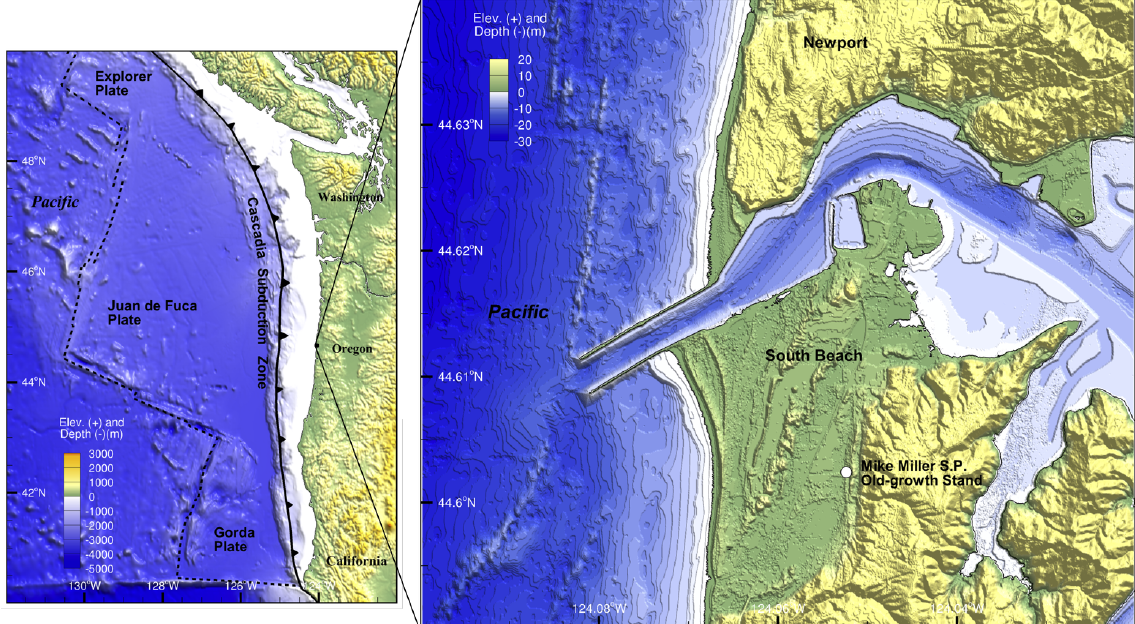
Figure 1. Map showing location of Newport and South Beach along the central Oregon coast. The white dot (at an elevation of 4m above mean higher high water, MHHW) shows the position of Mike Miller State Park in South Beach, which is the location of the Douglas-fir tree ( Pseudotsuga menziesii ) old growth stand whose ages extend back past 1700CE. The state park is located ∼ 2km south of the Yaquina Bay, Newport, ∼ 1 . 2km east of the shoreline and ∼ 600m east of Highway 101. Maps were created using digital elevation data points complied by the National Center for Environmental Information (http://ncei.noaa.gov, last access: September 2020) and the State of Oregon’s Department of Geology and Mineral Industries (https://www.oregongeology.org/lidar/, last access: September